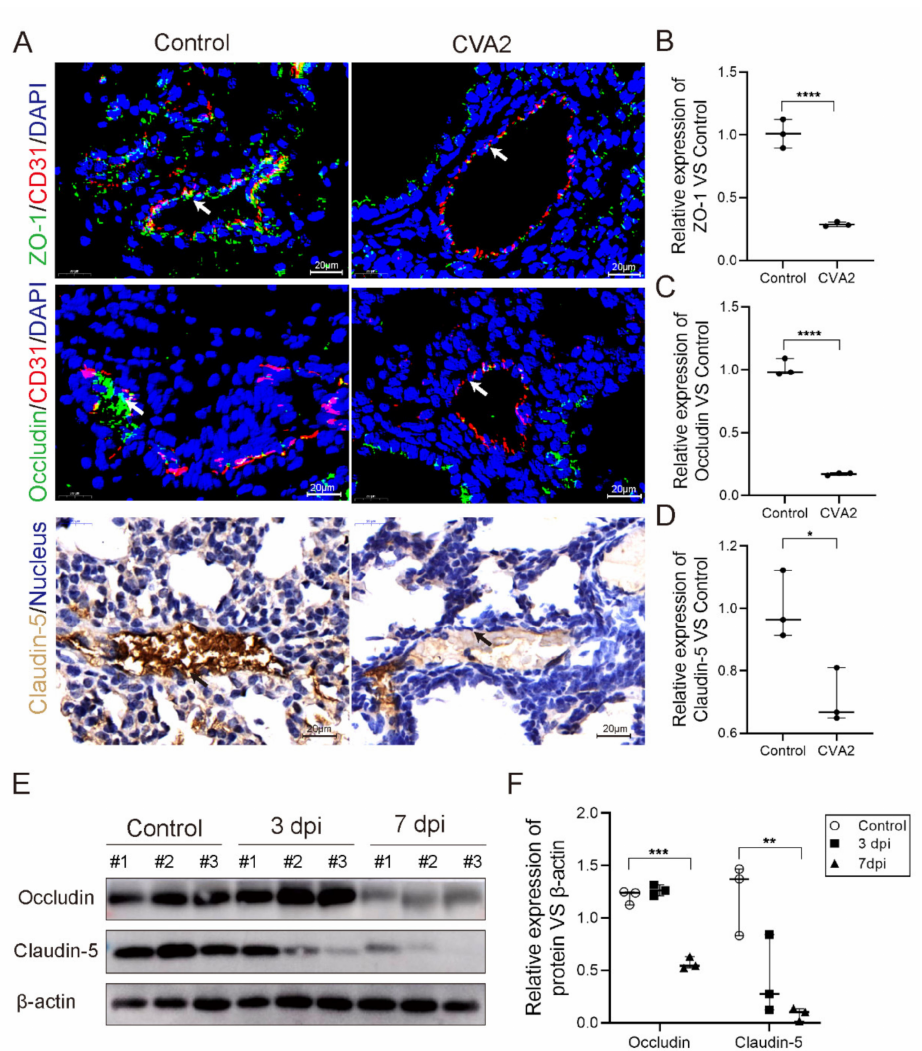
Figure 3. CVA2 infection led to the degradation of tight junction proteins in lung tissues. At 7 dpi, mice ( n = 3 per group) were euthanized, and related proteins of isolated lungs were determined. ( A ) Immunofluorescence staining of ZO-1 (red); occludin (red) and immunohistochemical staining of claudin-5 were conducted. The arrows indicate the pulmonary microvessel. The relative expression levels of ZO-1 ( B ), occludin ( C ) and claudin-5 ( D ) compared to control group were calculated by Image J software. ( E ) The immunoblot bands of occludin and claudin-5. ( F ) The quantification of occludin and claudin-5. n = 3 per group, data represent median with range. * p < 0.01; ** p < 0.01; *** p < 0.001; **** p < 0.0001 vs. control. All the experiments were repeated at least three